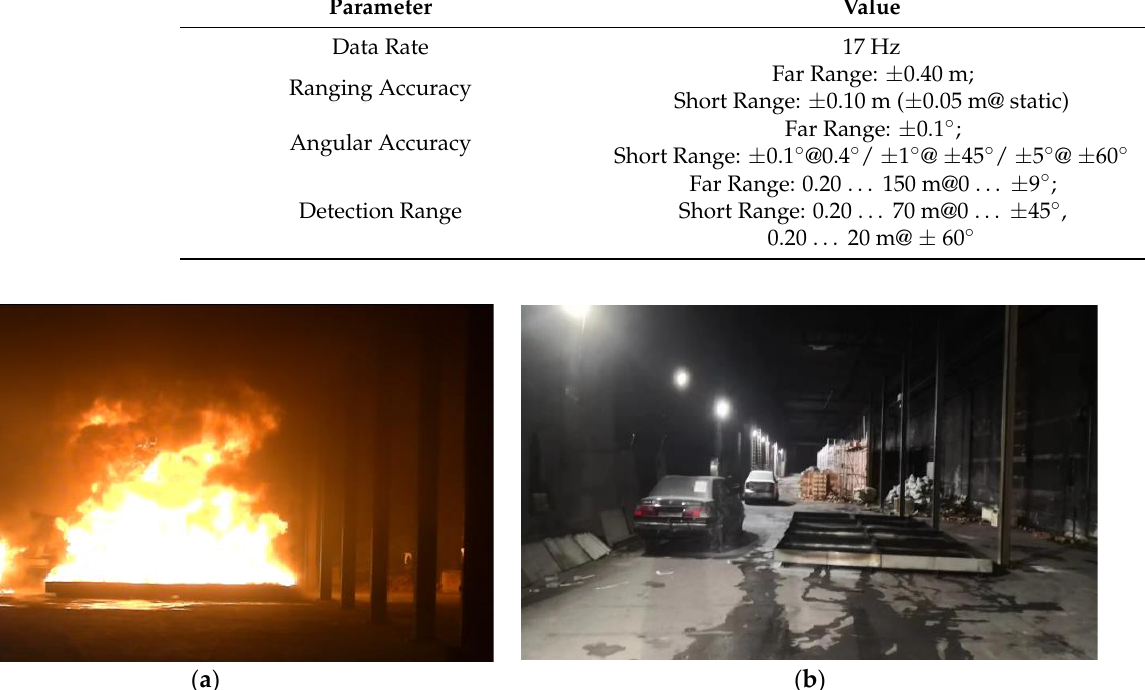
Figure 10. Experiment scene. ( a ) Fire smoke experiment. ( b ) Target scene.